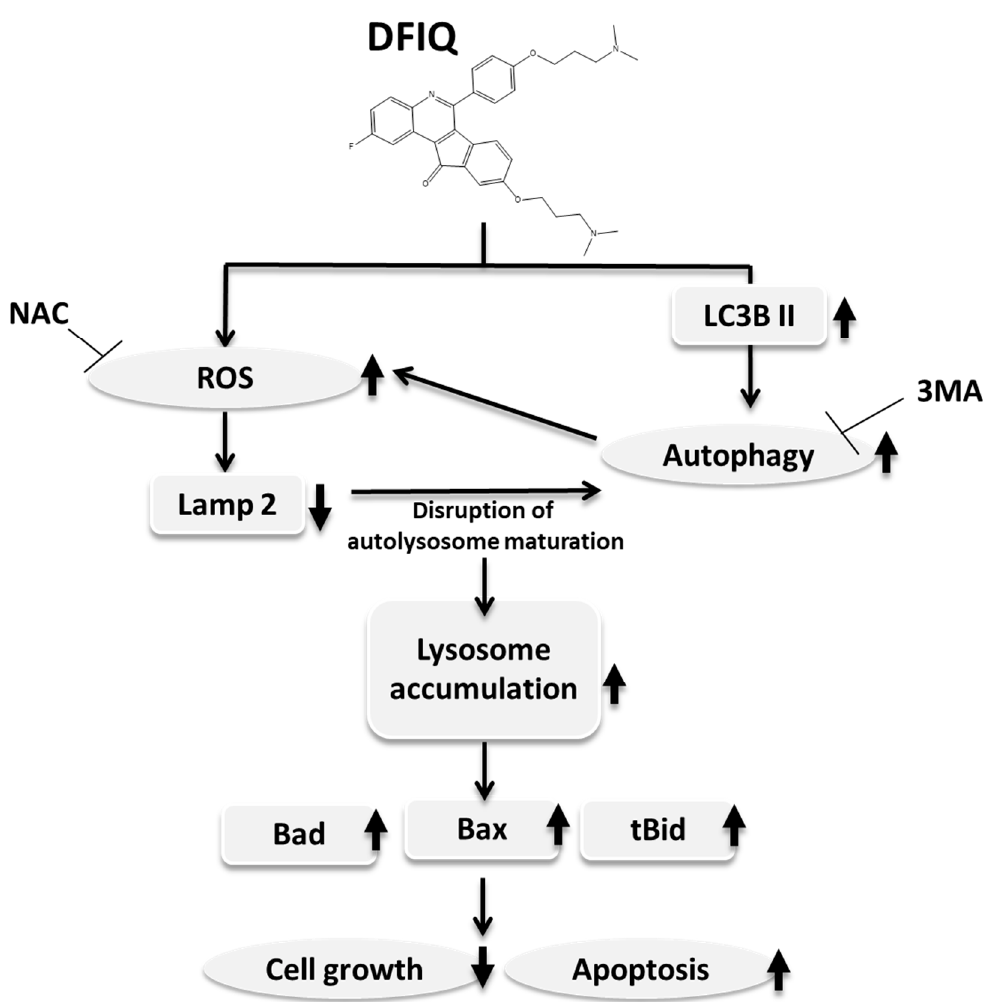
Figure 6. Proposed mechanism of DFIQ-induced apoptosis in lung cancer cells. DFIQ exerts anticancer potential that regulates the apoptosis of lung cancer cells. During DFIQ treatment, the level of O 2 − was significantly increased, but the metabolic function of O 2 − was disrupted, and the expression of the autophagolysosome formation-associated protein LAMP2 was downregulated, resulting in disruption of autophagolysosome maturation. On the other hand, DFIQ also induced the process of autophagy associated with ROS formation. Due to the disruption in autolysosome maturation and the induction of autophagy, lysosomes accumulate in cells treated with DFIQ, eventually inducing the expression of the apoptotic proteins Bad, Bax, and tBid and thus causing